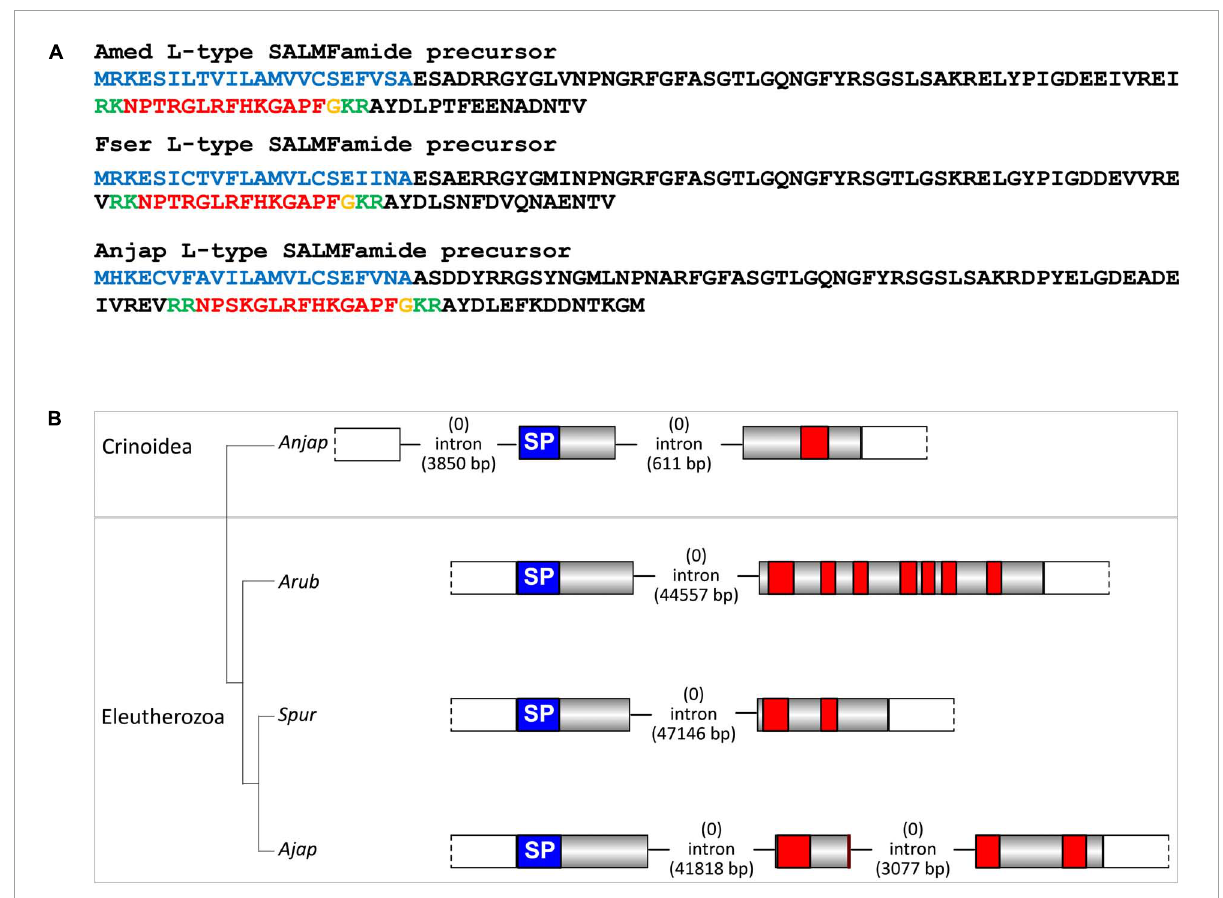
FIGURE7 Crinoid L-type SALMFamide precursors and comparison of gene structure with eleutherozoan L-type SALMFamide precursor genes. (A) Sequences of L-type SALMFamide precursors in three crinoid species, Antedon mediterranea (Amed), Florometra serratissima (Fser), and Anneissia japonica (Anjap). The predicted signal peptide is shown in blue, predicted dibasic cleavage sites are shown in green and predicted neuropeptides are shown in red, but with C-terminal glycine residues that are potential substrates for post-translational amidation shown in orange. (B) Structure of the L-type SALMFamide precursor gene in the crinoid Anneissia japonica (Anjap) compared with the structures of L-type SALMFamide precursor genes in eleutherozoans, including the starfish Asterias rubens (Arub), the sea urchin Strongylocentrotus purpuratus (Spur), and the sea cucumber Apostichopus japonicus (Ajap). In all four species there is phase 0 intron located between an exon encoding the signal peptide and an exon or exons encoding the SALMFamide neuropeptides, which provides additional evidence that these genes are orthologs. The A. japonica gene has a second phase 0 intron preceding the start codon encoding the first methionine of the signal peptide and the A. japonicus gene also has a second phase 0 intron that interrupts the coding sequence for the second predicted SALMFamide